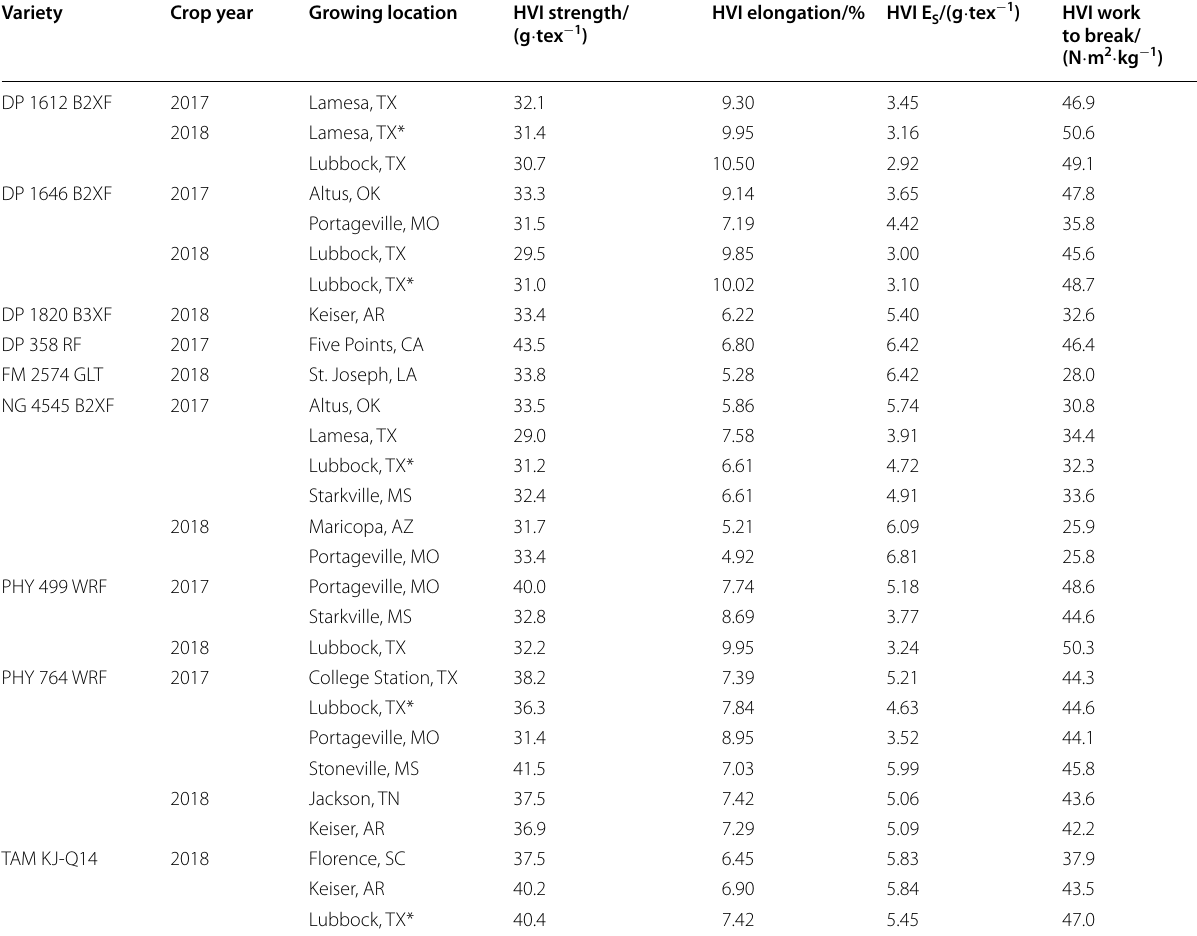
*Indicates dryland (rainfed only) production, all other samples were produced with irrigation